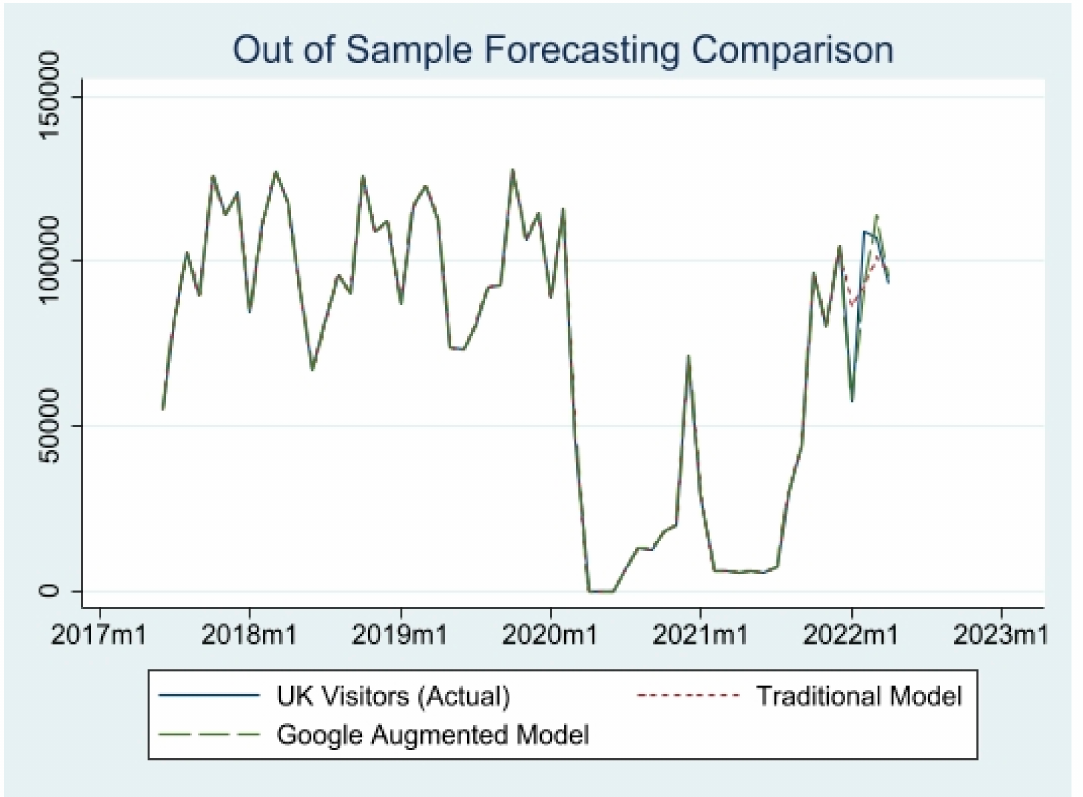
Figure 4. Forecasting